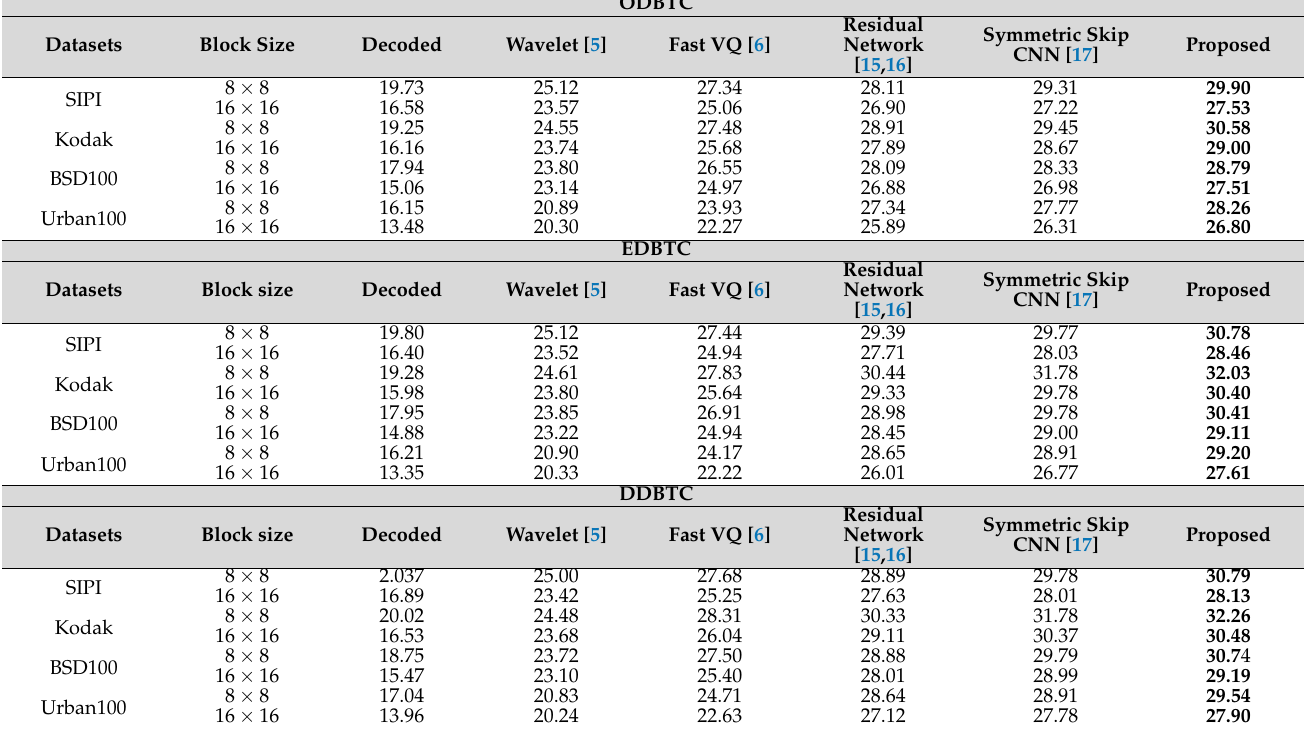
Table 1. Performance comparison between the proposed method and former schemes in terms of PSNR value.